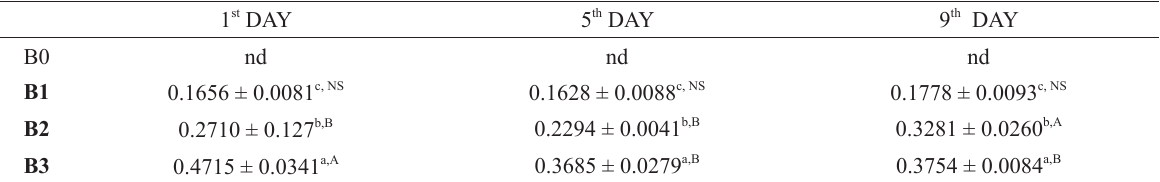
β-carotene (µg/g) in breads made with sweet potato flour during storage *